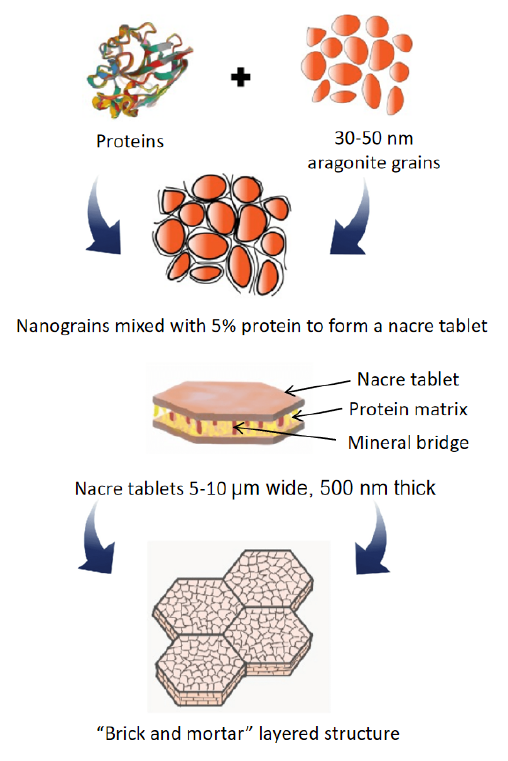
Figure 1. Schematic showing hierarchical brick and mortar layered structure of nacre at multiple length scales (Inspired from [7]). The Top left figure of a protein (chitin) has been adapted from the Protein Data Bank (PDB ID: 1ZTY)